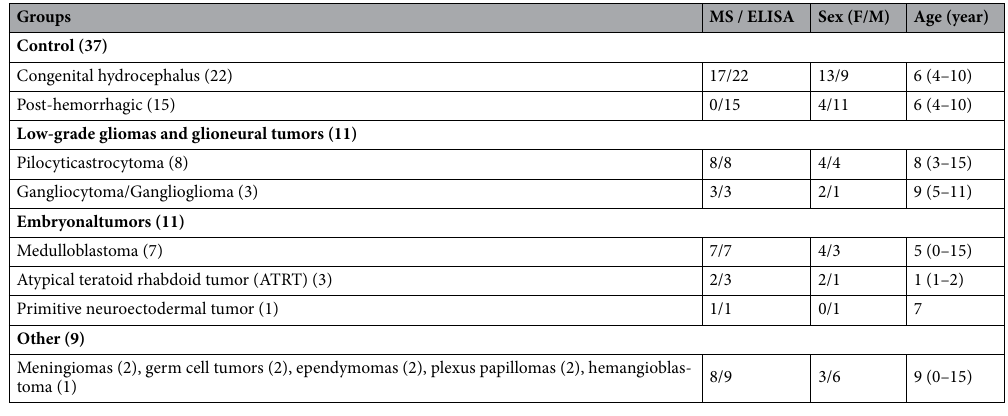
Table 2. Clinical characteristics of the sixty-eight patients enrolled in the study. All patients with Brain tumors had a histological diagnosis. The abbreviations MS and ELISA correspond to samples (i.e. patients) analysed by mass spectrometry (46) and/or ELISA assay (68), respectively. The total number of patients in each clinical group is reported in brackets. Age is reported as years (median and